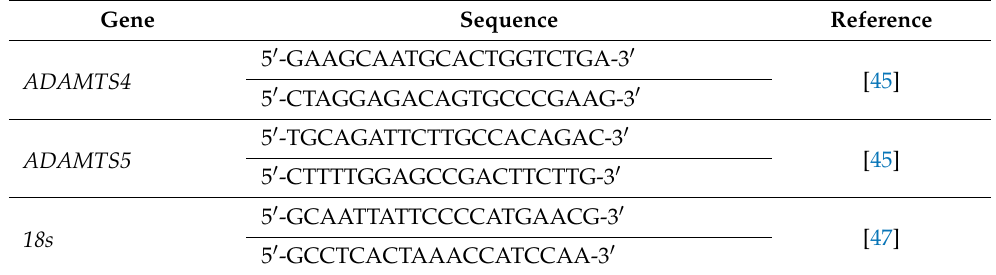
Table 1. Cont. Gene Sequence